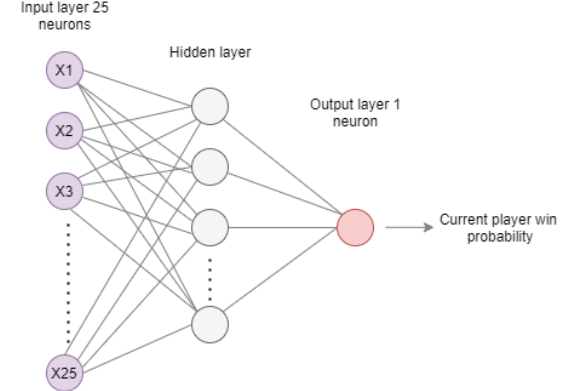
Figure 8. Rival neural network